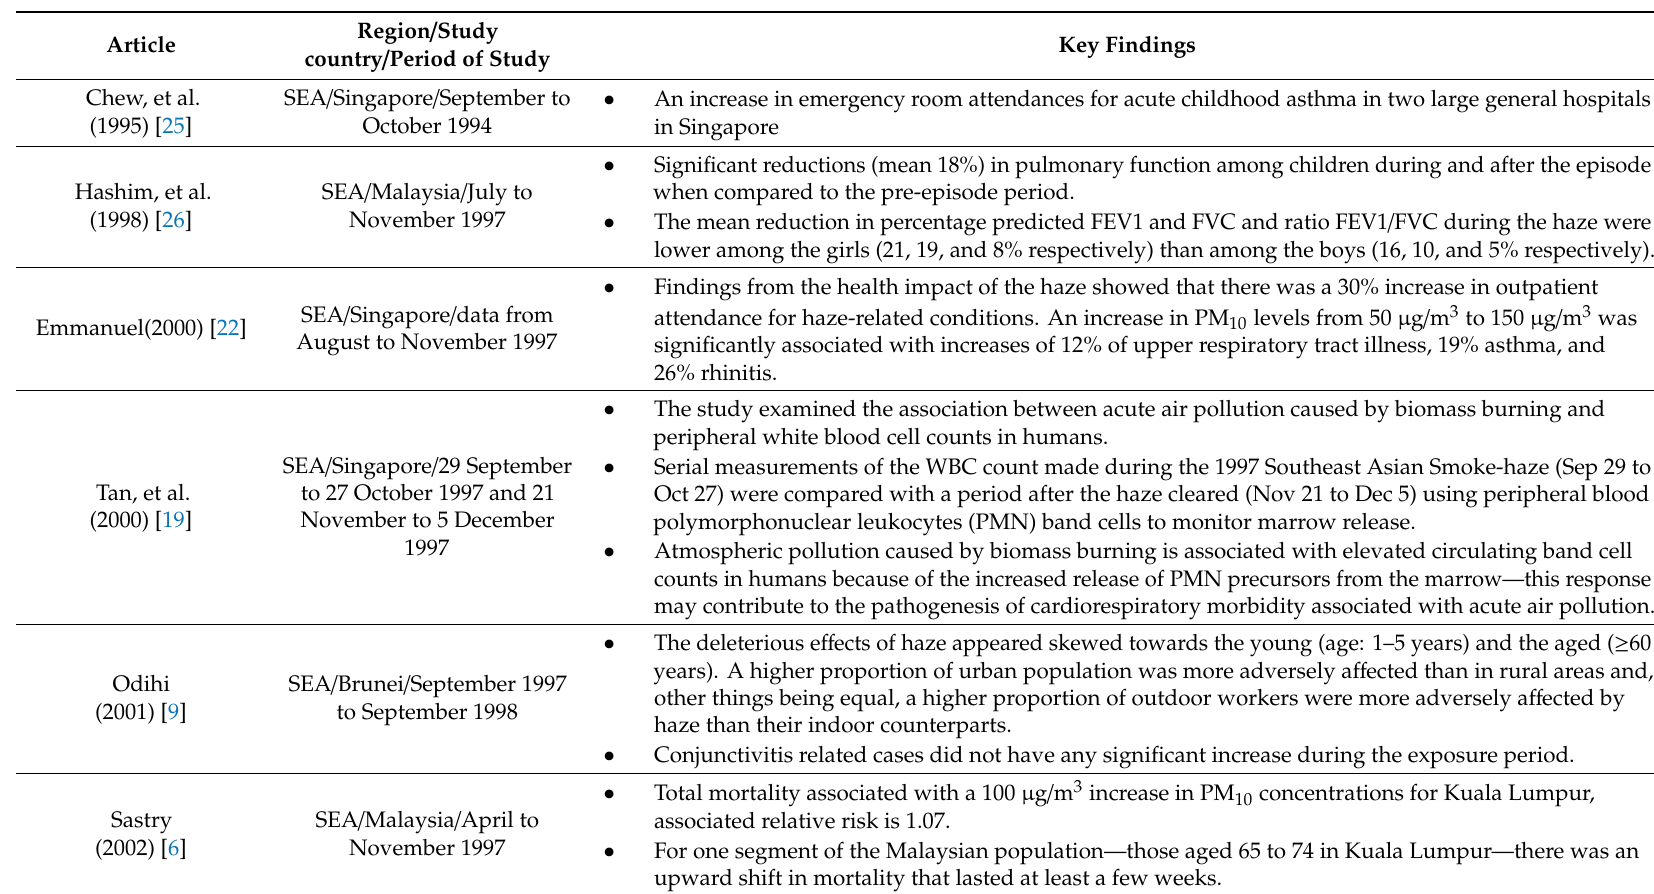
Table 1. Key findings of haze-related health